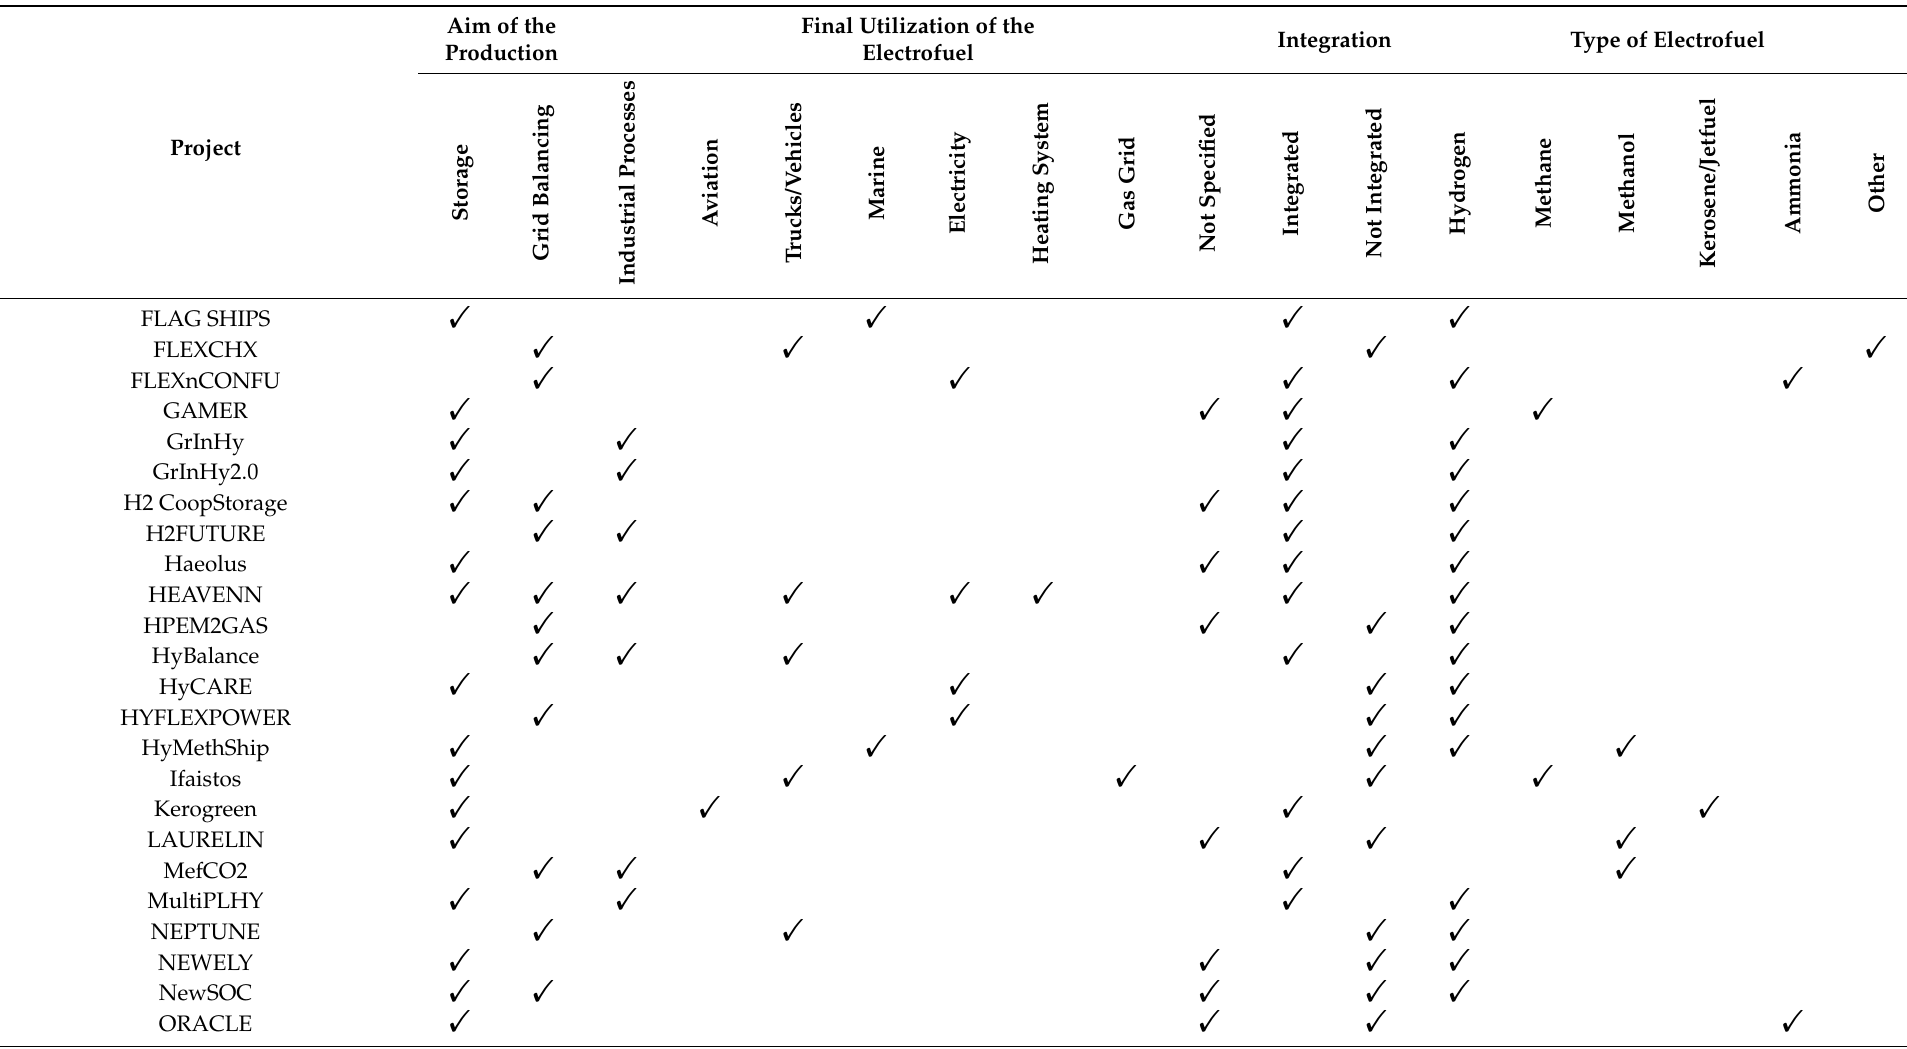
Integration Type of